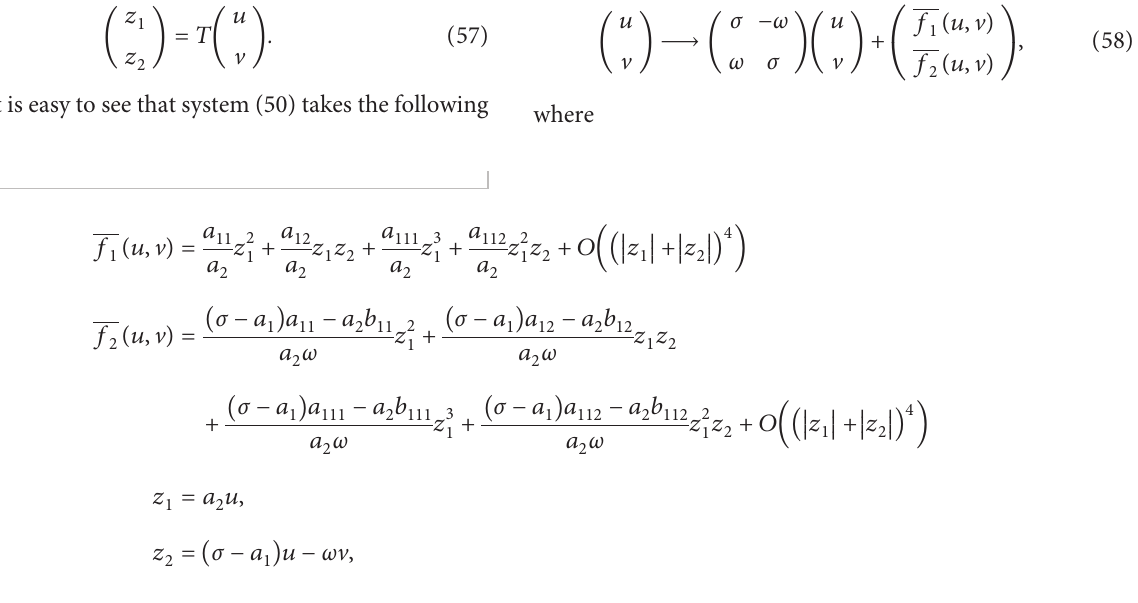
n . (b) Bifurcation diagram for y n . (c) Bifurcation